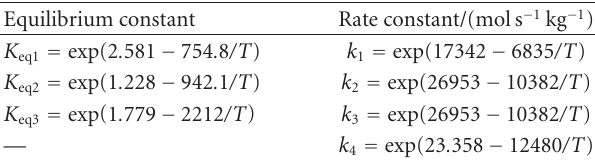
Table 1: Equilibrium constants and rate constants